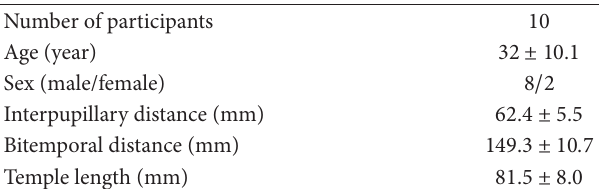
Table 1: Demographic